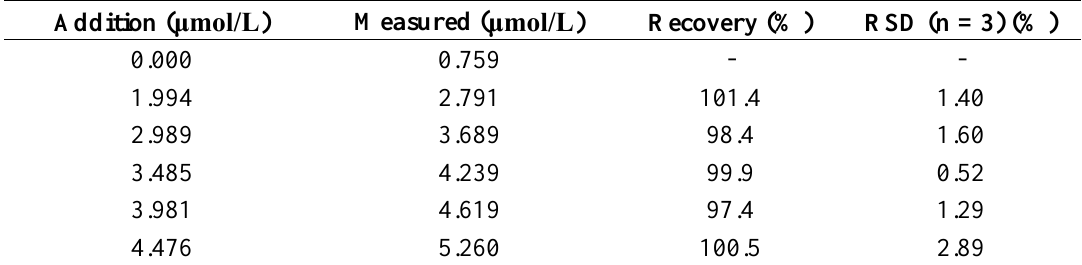
Table 2. Determination of quercetin in apple juice with MIP/GO/GC by using the standard addition